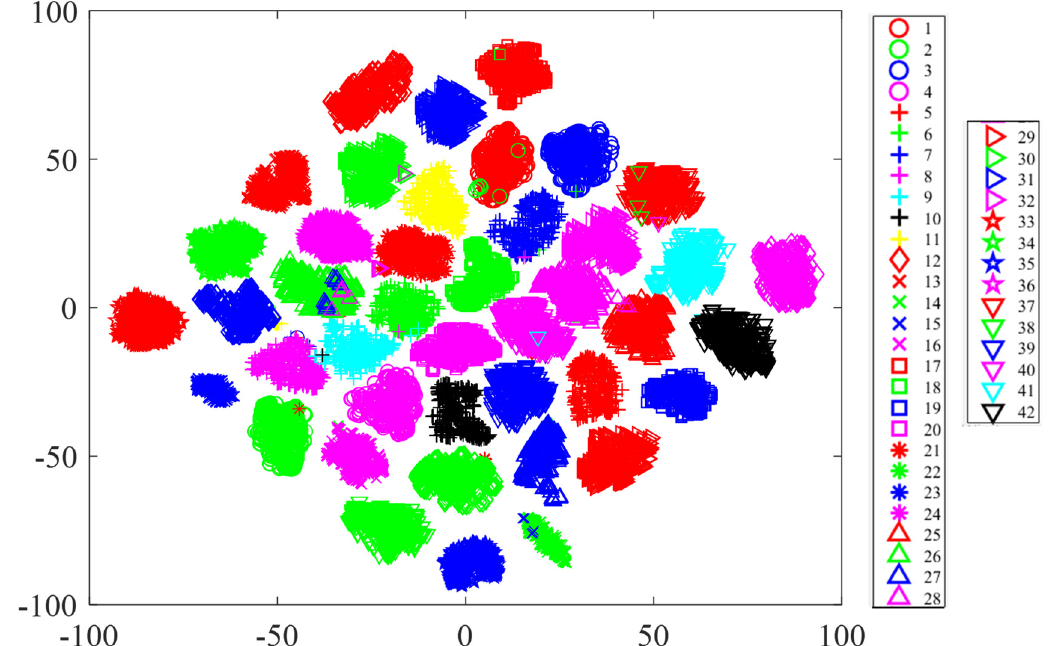
Figure 17. Visualization of the activations from layer “pool5” of ResNet18 on the augmented data via PCA and t-SNE. (1: normal; 2–8: unbalance with (6, 10, 15, 20, 25, 30, 35) g mass; 9–12: horizontal misalignment of (0.5, 1, 1.5, 2) mm; 13–18: vertical misalignment of (0.51, 0.63, 1.27, 1.4, 1.78, 1.9) mm; 19–22: overhung position ball fault with (0, 6, 20, 35) g unbalance; 23–26: overhung position cage fault with (0, 6, 20, 35) g unbalance; 27–30: overhung position outer race fault with (0, 6, 20, 35) g un-balance; 31–34: underhung position ball fault with (0, 6, 20, 35) g unbalance; 35–38: underhung position cage fault with (0, 6, 20, 35) g unbalance; 39–42: underhung position outer race fault with (0, 6, 20, 35) g unbalance). (Refer to online color version for clarity).